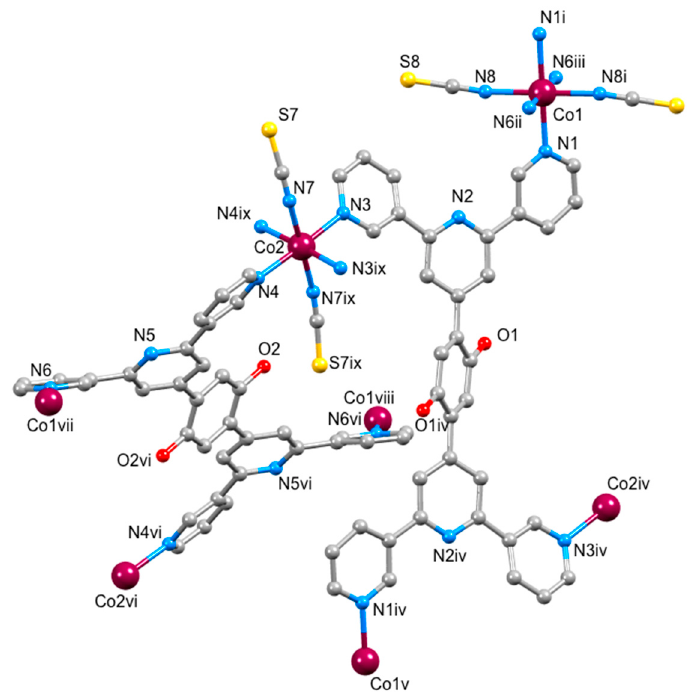
Figure 4. The repeat unit in the coordination network of [{Co( 1 )(NCS) 2 } · MeOH · 3CHCl 3 ] n with symmetry-generated atoms. For clarity, H atoms and solvent molecules are omitted, and only the O atoms of the alkoxy groups are shown. Symmetry codes: i = 1 / 2 − x , 1 / 2 − y , − z ; ii = 1 − x , − 1 + y , 1 / 2 − z ; iii = − 1 / 2 + x , 3 / 2 − y , − 1 / 2 + z ; iv = 1 − x , 1 − y , 1 − z ; v = 1 / 2 + x , 1 / 2 + y , 1 + z ; vi = 1 − x , 2 − y , 1 − z ; vii = 1 − x , 1 + y , 1 / 2 − z ; viii = 1 / 2 − x , 1 / 2 + y , 1 / 2 − z ; ix = 1 − x , y , 1 / 2 − z . For an ORTEP-style figure of the asymmetric unit, see Figure S9 in the Supplementary material. Table 1. Important bond lengths in [{Co( 1 )(NCS) 2 } · MeOH · 3CHCl 3 ] n and [{Co( 2 )(NCS) 2 } · 0.8MeOH · 1.8CHCl 3 ] n .